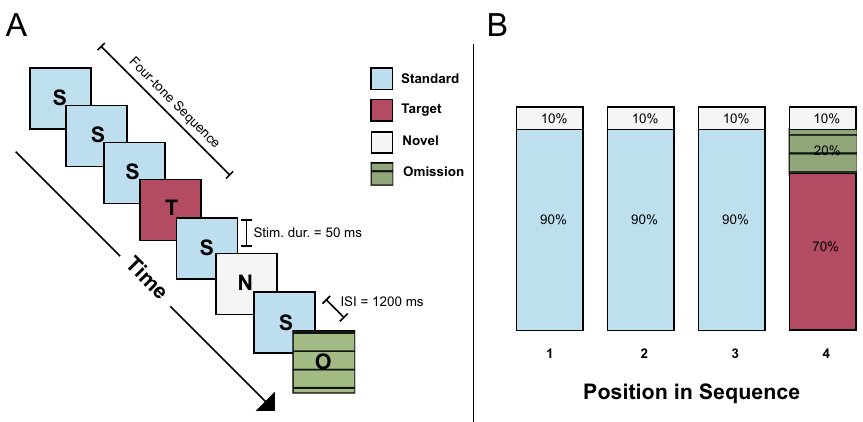
Figure 1. ( A ) Schematic of the auditory oddball paradigm. Auditory stimuli were tones presented for 50 ms each, with an inter-stimulus interval of 1200 ms. Each tone belonged to one of four stimulus categories— standard, target, novel, and omission. Participants were instructed to press the spacebar whenever they heard a target tone. All stimuli were grouped into larger sequences comprising four tones. ( B ) shows the percentage of time that stimuli from each category appeared at each position in the four-tone sequence. Figure created using Adobe Illustrator (Adobe Inc., 2020; Retrieved from https:// adobe. com/ produ cts/ illus